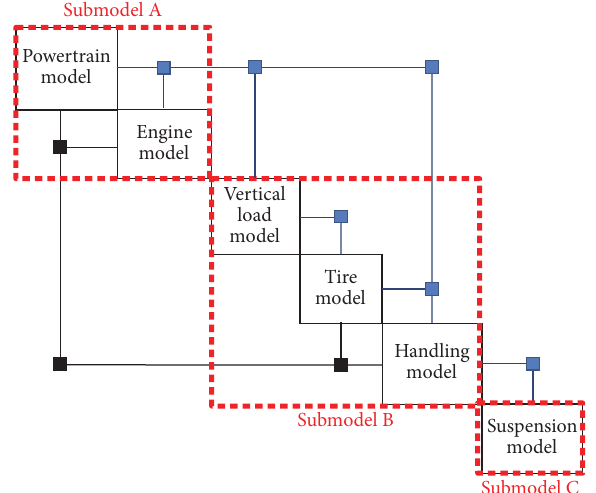
Figure 6: Partitioned UTMVDM for surrogate